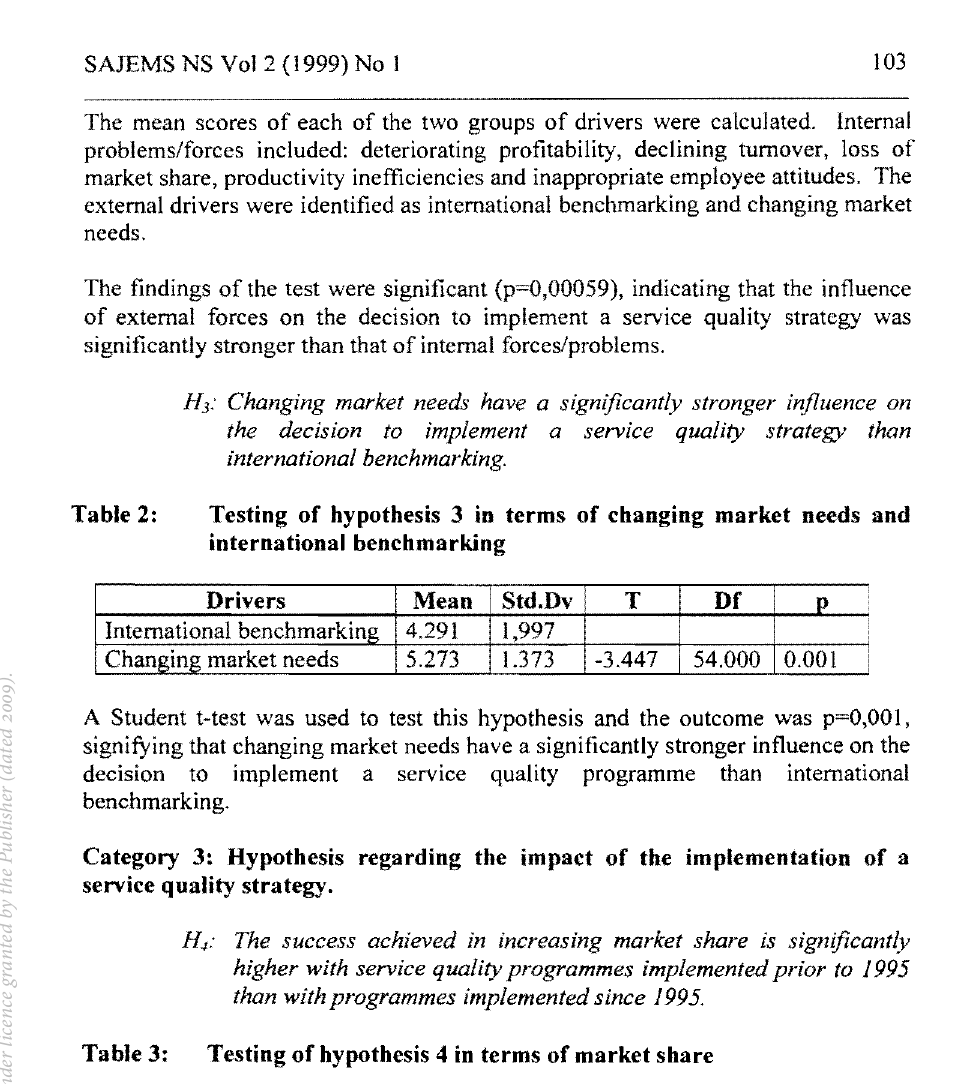
H3: Changing market needs have a significantly stronger influence on the decision to implement a service quality strategy than international benchmarking.